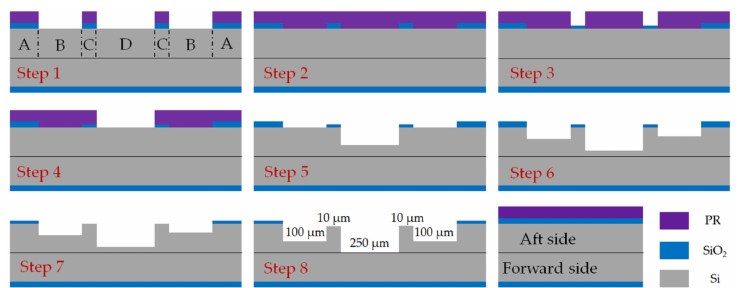
Figure 9. Process flow of traditional method for DRIE multi-depth structures on aft side of the second layer in